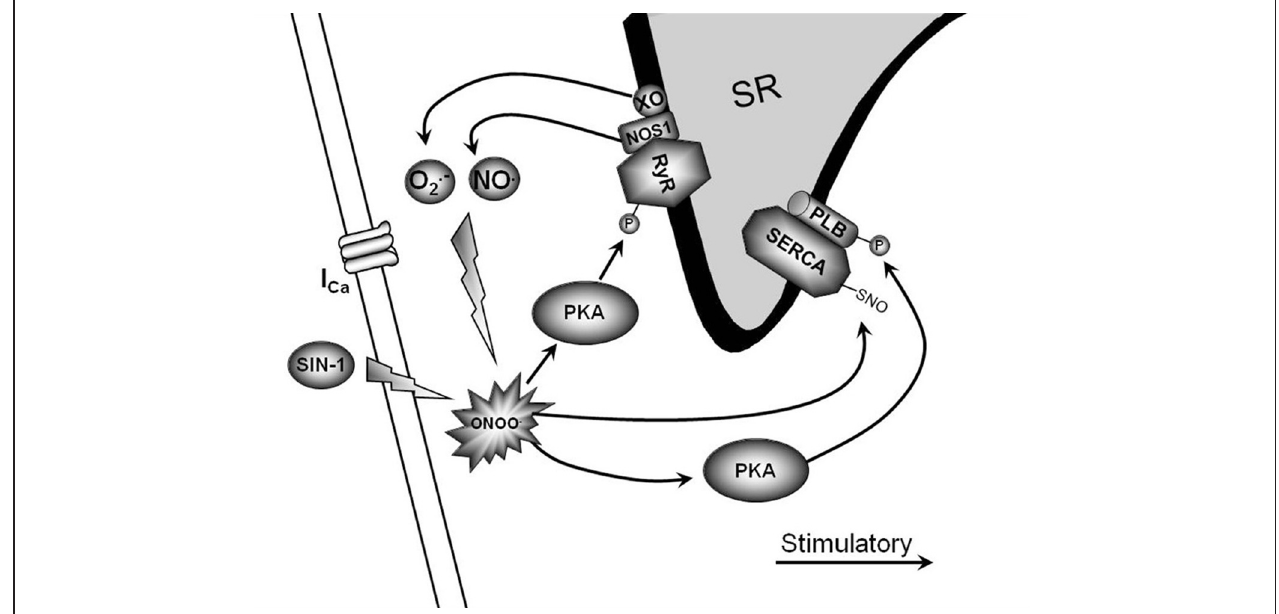
FIGURE 1 | Physiological signaling pathway of low peroxynitrite. This is a diagrammatic representation of low peroxynitrite signaling and various proposed end targets within the cardiomyocyte. The endogenous production of low peroxynitrite can occur via NOS1/xanthine oxidase.